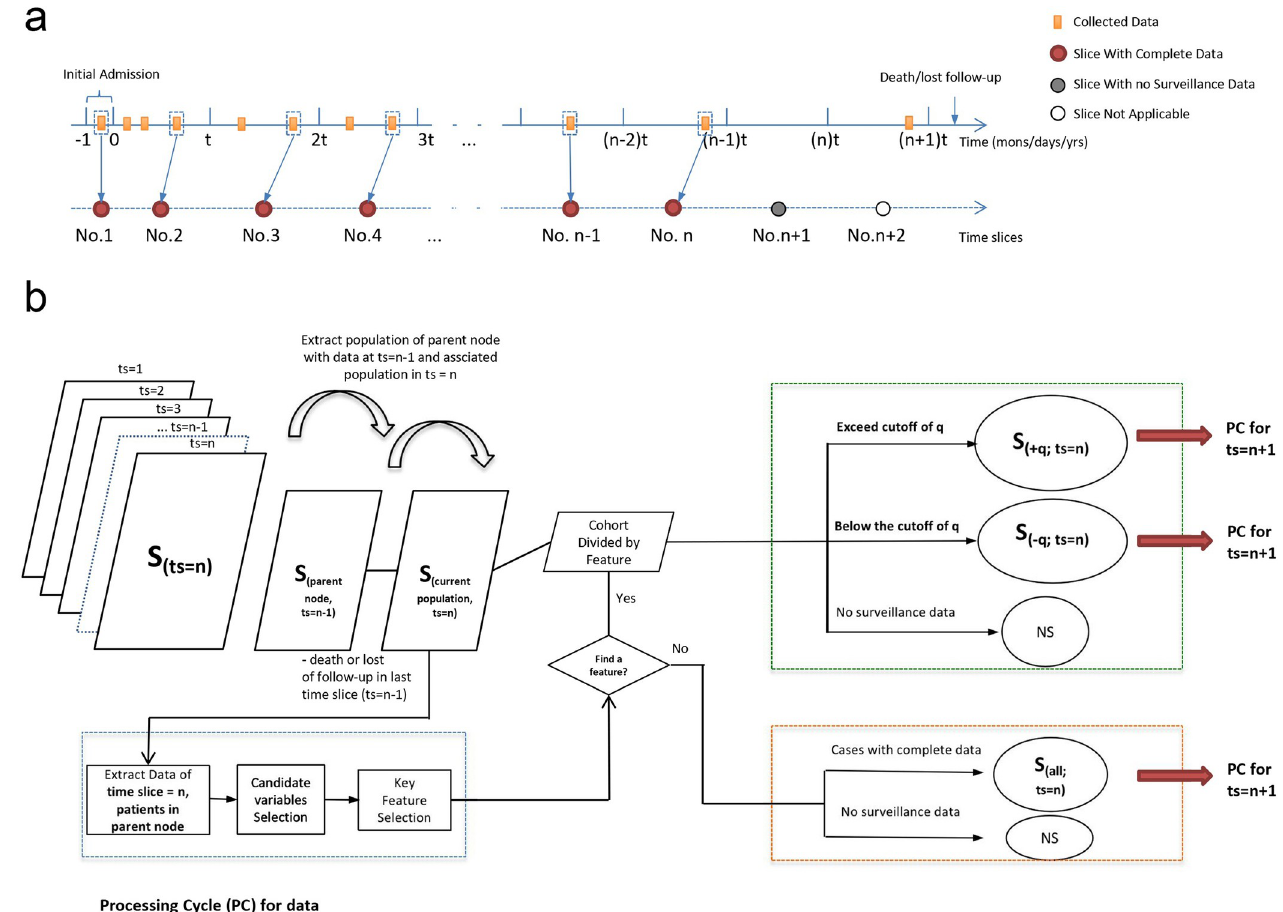
Fig 1. Flowchart of analysis for survival path mapping. (A) The time-series data of participants were converted into data of time slices with constant time interval. (B) Starting from the first time slice, data of the whole population would initially undergo the processing cycle (PC) for feature selection and subgroup subdivision, followed by PC in each subdivided subgroup data at the next time slice. The subdivision of parent node in the No. (n-1) time slice determine the population of the nodes in No.n time slice. The program continue until user defined last time slice.